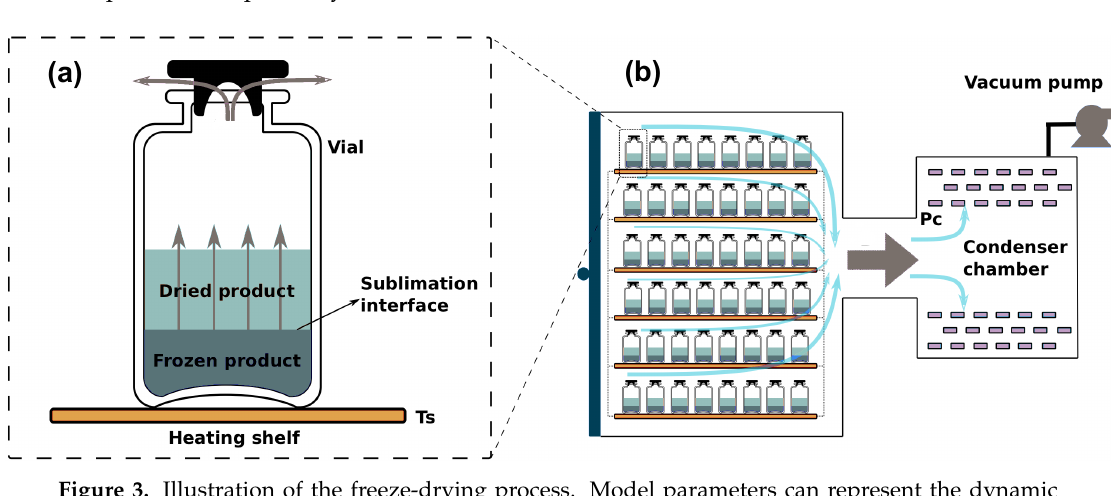
Figure 3. Illustration of the freeze-drying process. Model parameters can represent the dynamic processes of a single vial ( a ) appropriately, but may fail for all vials that are handled in the freeze-dryer ( b ) due to batch-to-batch